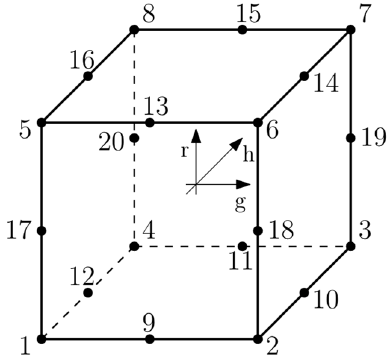
Figure 6. C3D8R element designations [29].